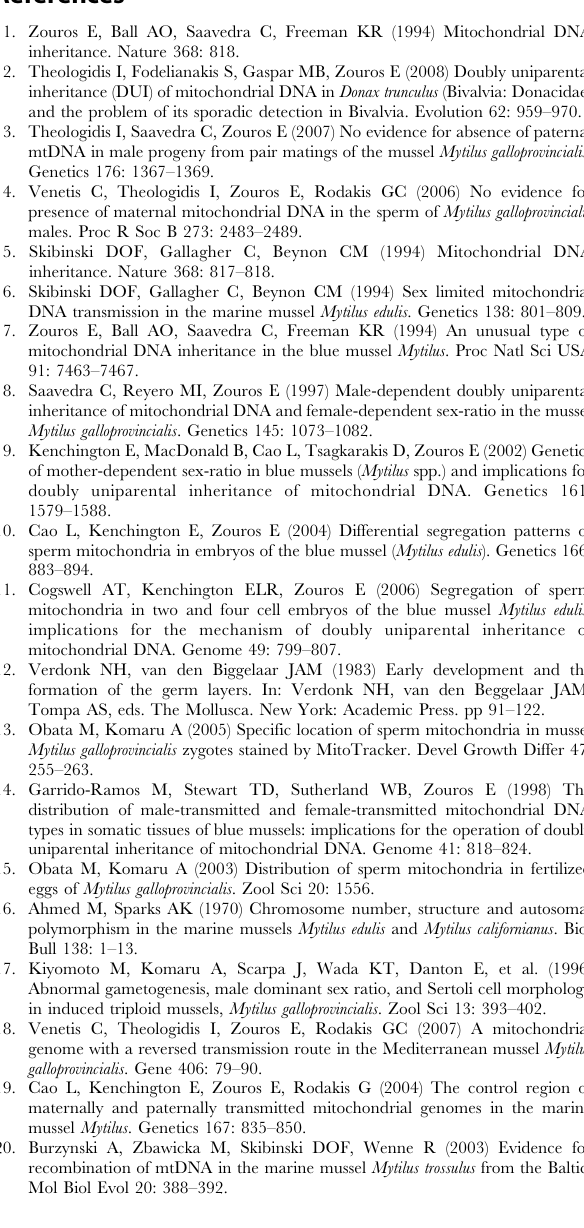
Protocol S3 Details Protocols of Spawning, Fluorescent Label- ling of Sperm, Induction of Triploidy and Rearing of Progeny from